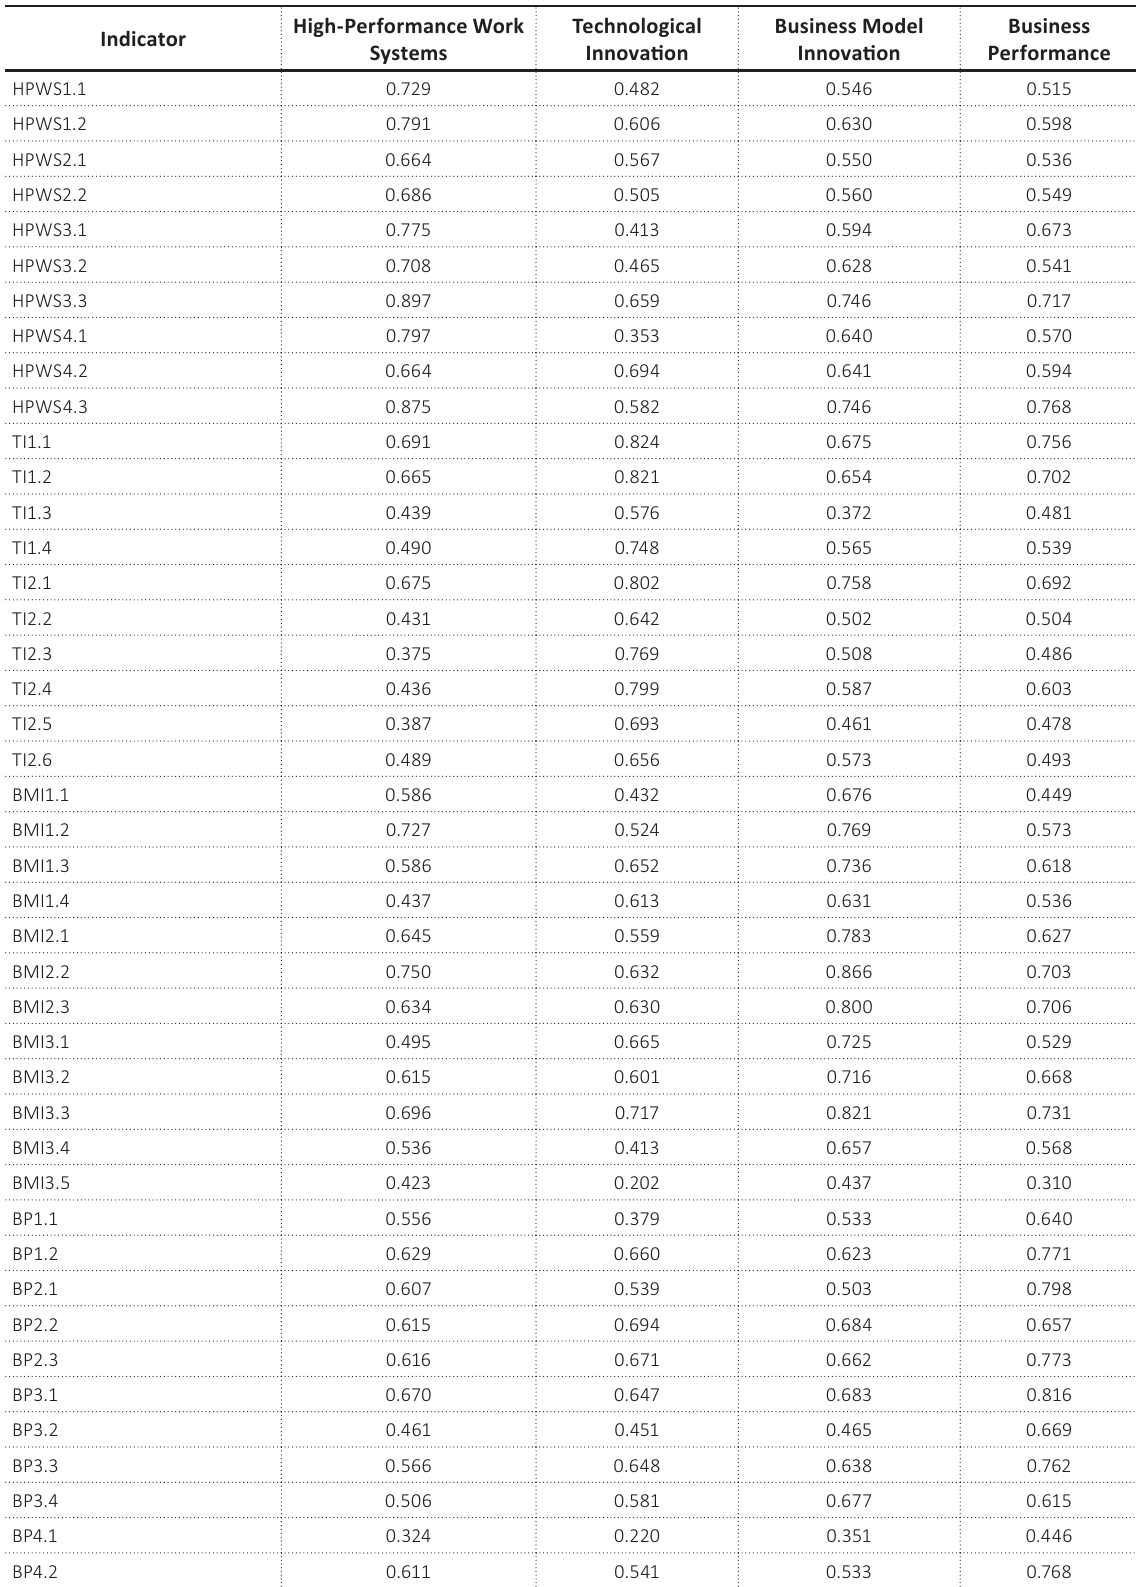
Table 4. Discriminant validity results ( n =